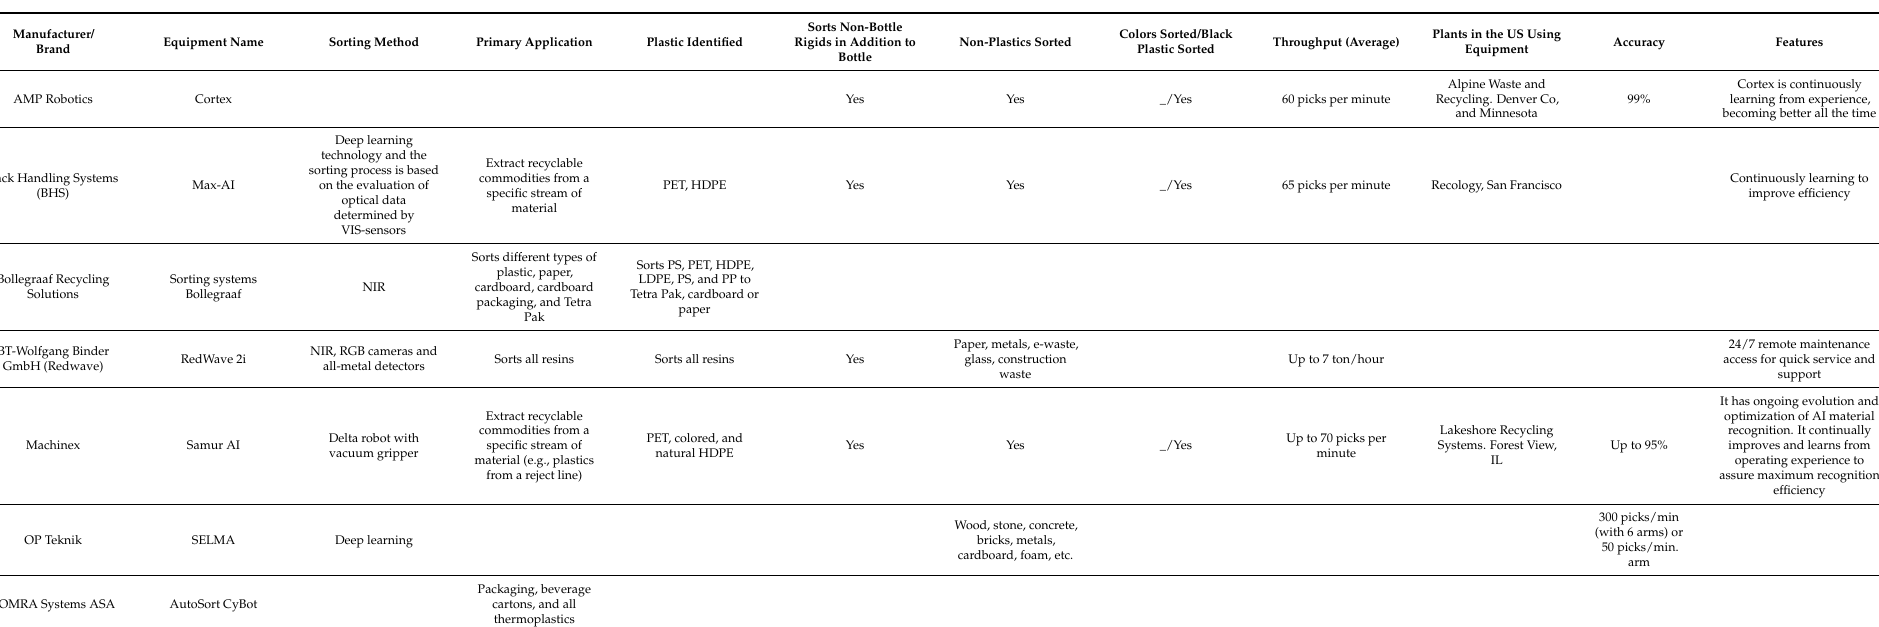
Table 6. Inventory of emerging AI-based